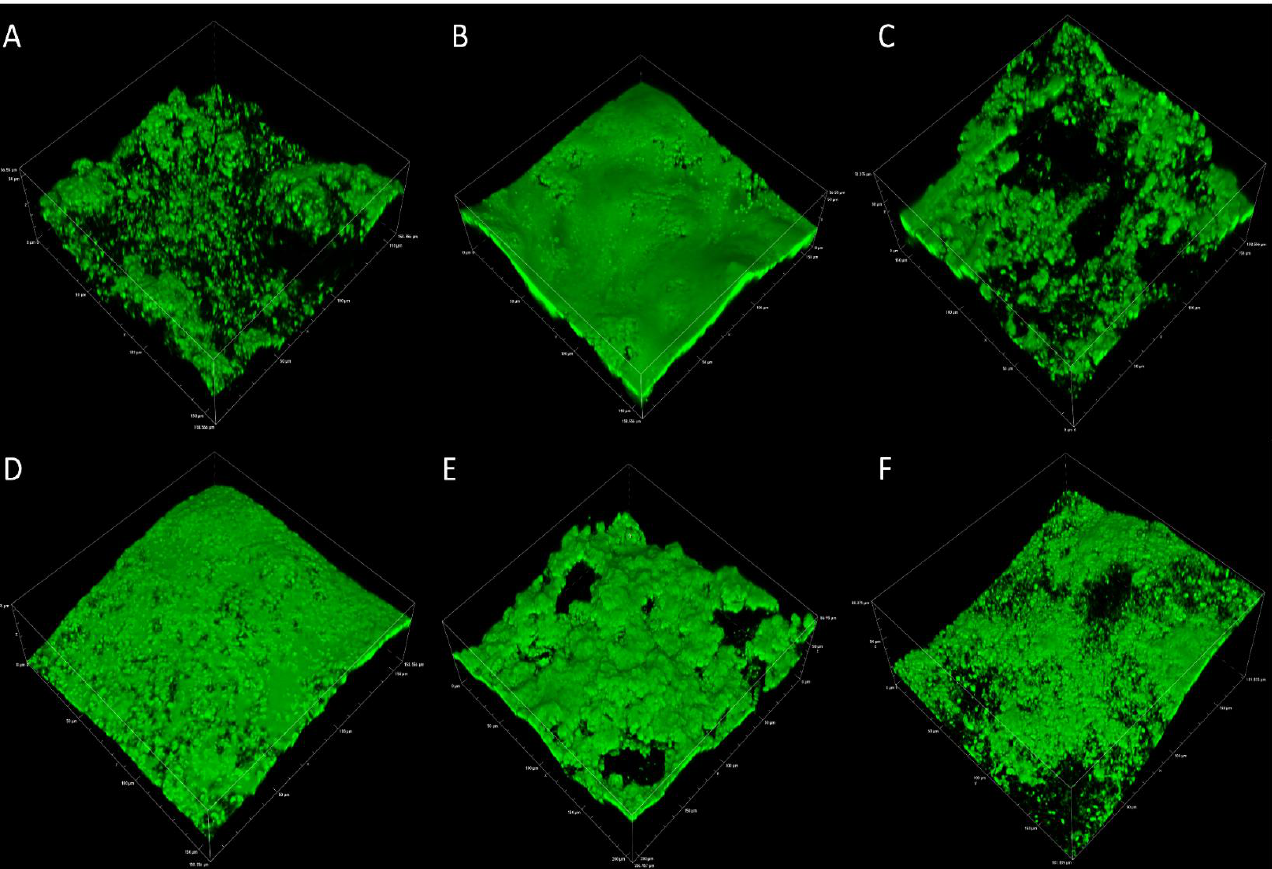
Figure 3. Representative CLSM of eDNA in multispecies biofilms after 2, 4, and 6 weeks for experimental replicate 1 ( A – C ) and experimental replicate 2 ( D – F ).